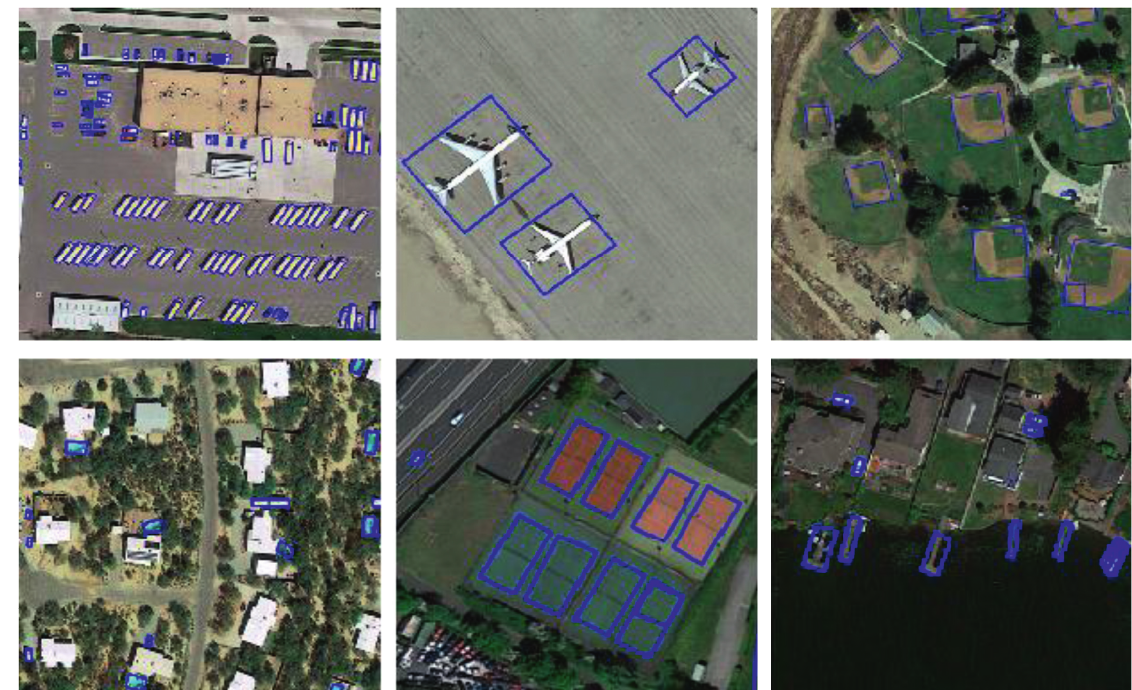
Figure 8: HRSC2016 dataset